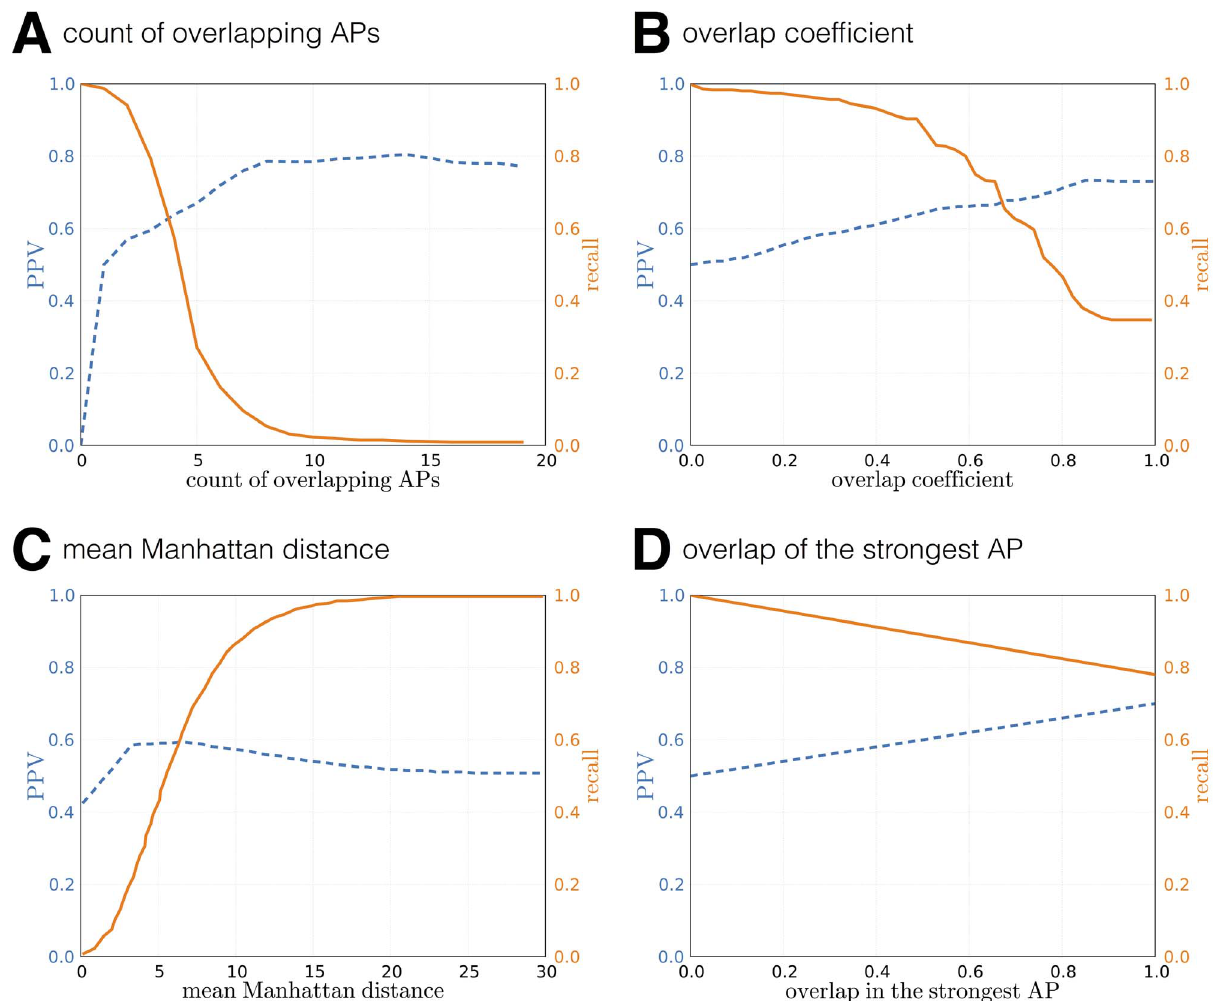
Figure 7. WiFi similarity measures. Positive predictive value (precision, ratio of number of true positives to number of positive calls, marked with dashed lines) and recall (sensitivity, fraction of retrieved positives, marked with solid lines) as functions of parameters in different similarity measures. A ) In 98% of face-to-face meetings derived from Bluetooth, the two devices also sensed at least one common access point. D ) Identical strongest access point for two separate mobile devices is a strong indication of a face-to-face